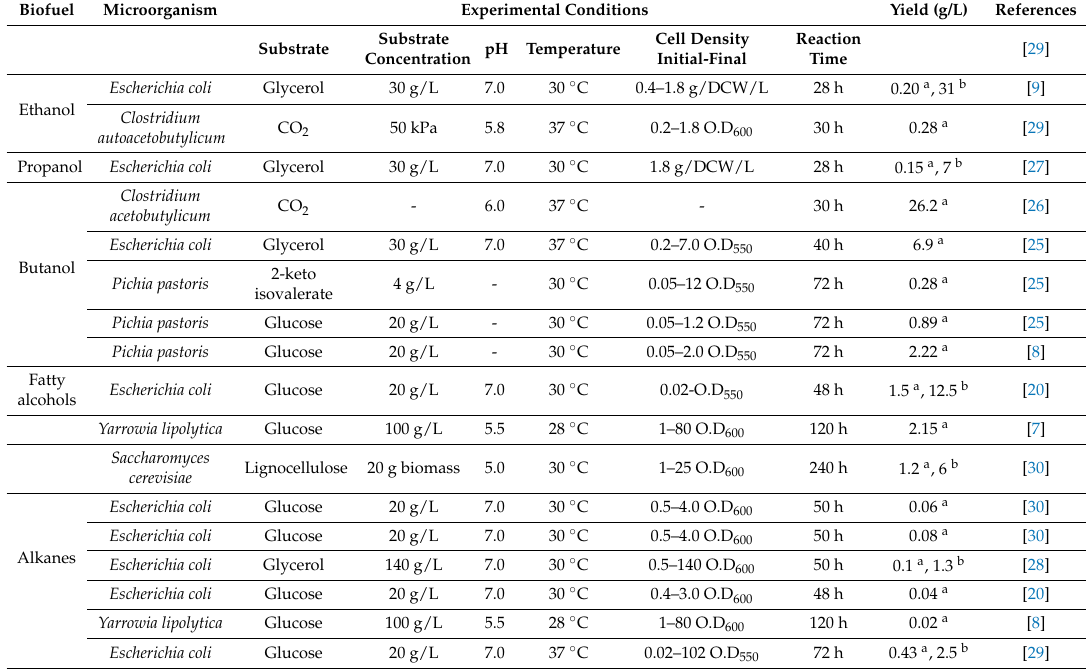
Table 2. Comparison of experimental parameters of biofuel production in